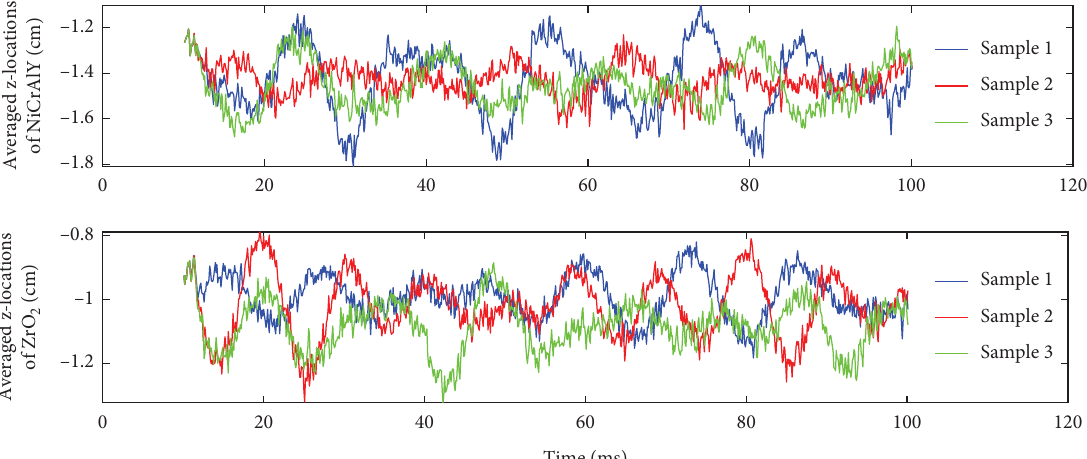
Figure 8: Variations of averaged z-locations of injectors for (a) NiCrAlY and (b) ZrO shown in Figure